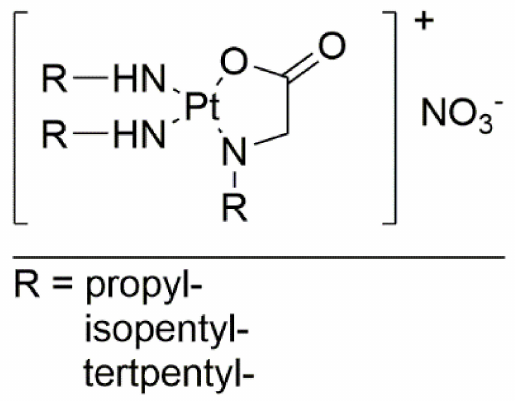
Figure 5. Novel platinum complexes with glycine